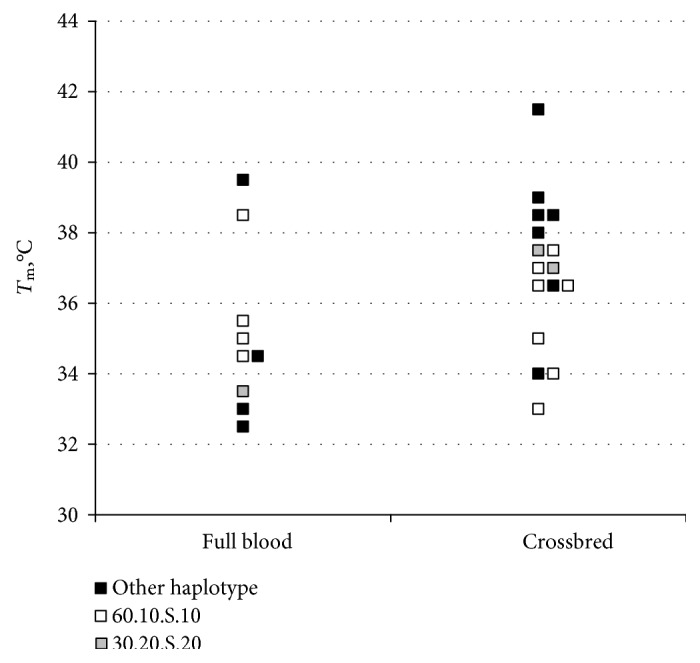
Crossbreds perform as Wagyu if they possess a Wagyu haplotype. Tm measurements from 9 full blood and 16 crossbred entries to AWA branded beef competition from 2014 and 2015. There are crossbred Wagyu with Tm as low as full bloods. Mean Tm with error bars ± 1 SEM. SREB-TCAP haplotypes. White squares indicate animals with at least one 60.10.S.10 haplotype, pale grey squares indicate animals with at least one 30.20.S.20 haplotype, and dark grey squares indicate animals with neither common Wagyu haplotype.